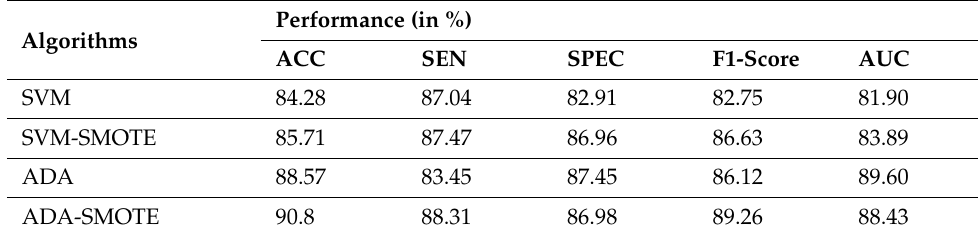
Table 3. Performance of popular AI systems using hold out cv.